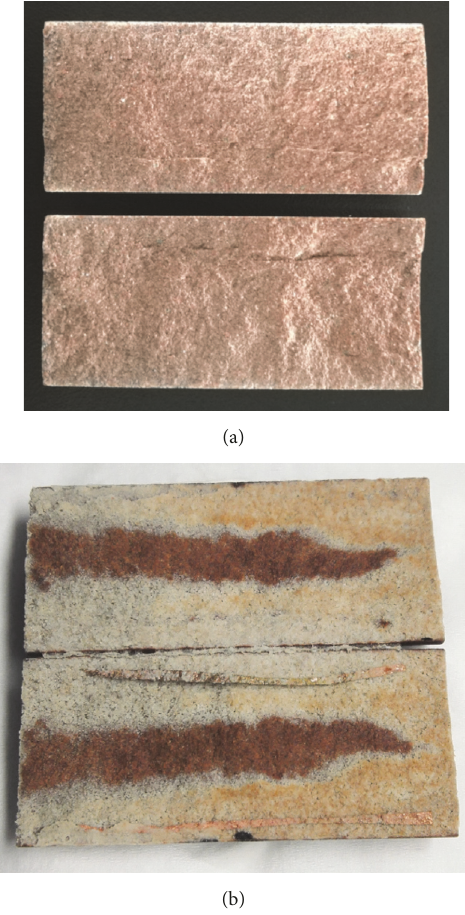
Figure 10: Topography of fracture face before (a) and after (b) acidizing treatment.